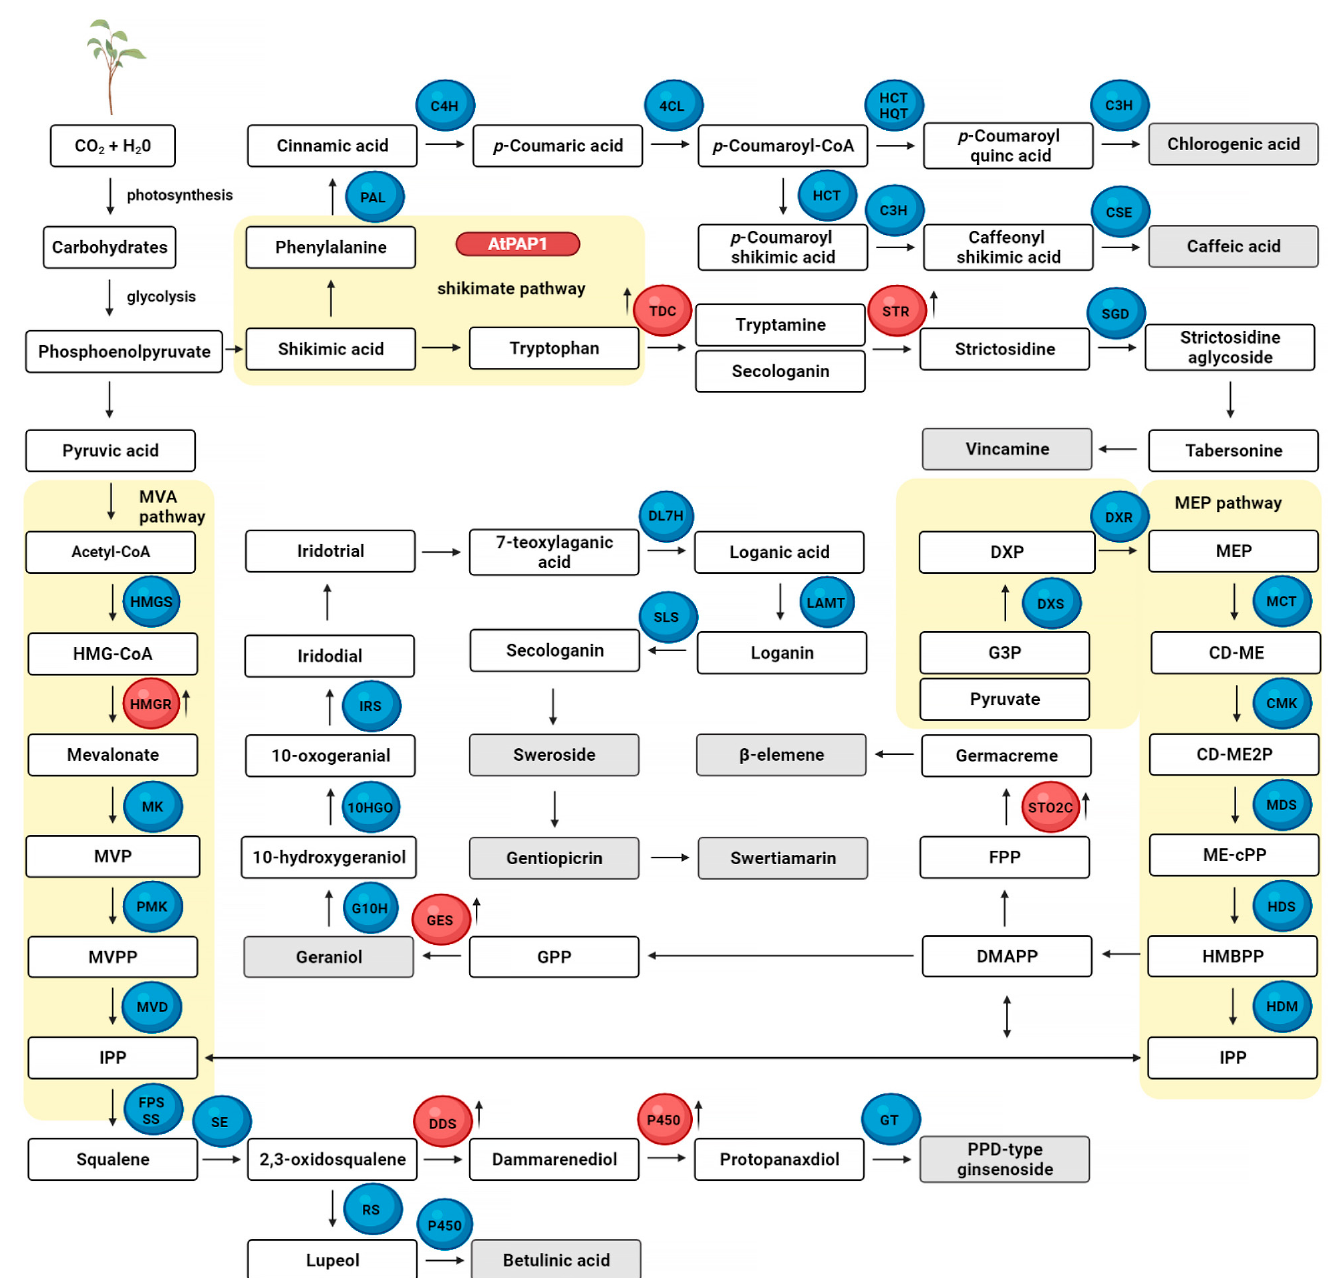
Figure 3. Schematic of the selected secondary metabolite biosynthesis pathway of transgenic plants with incorporated genes. The enzymes marked in red are expressed by plant species presented in Table 1.